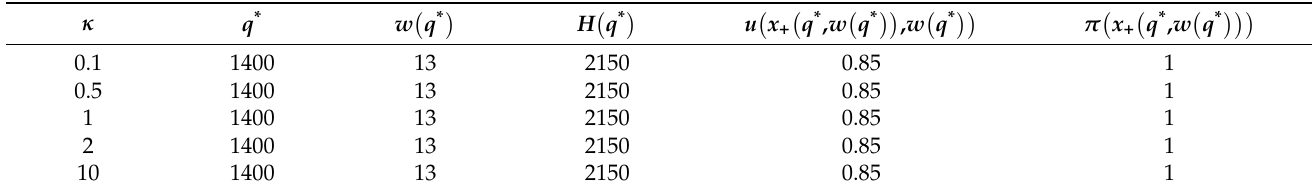
Table 1. Solutions of the proposed model with ϕ = 0.1 .